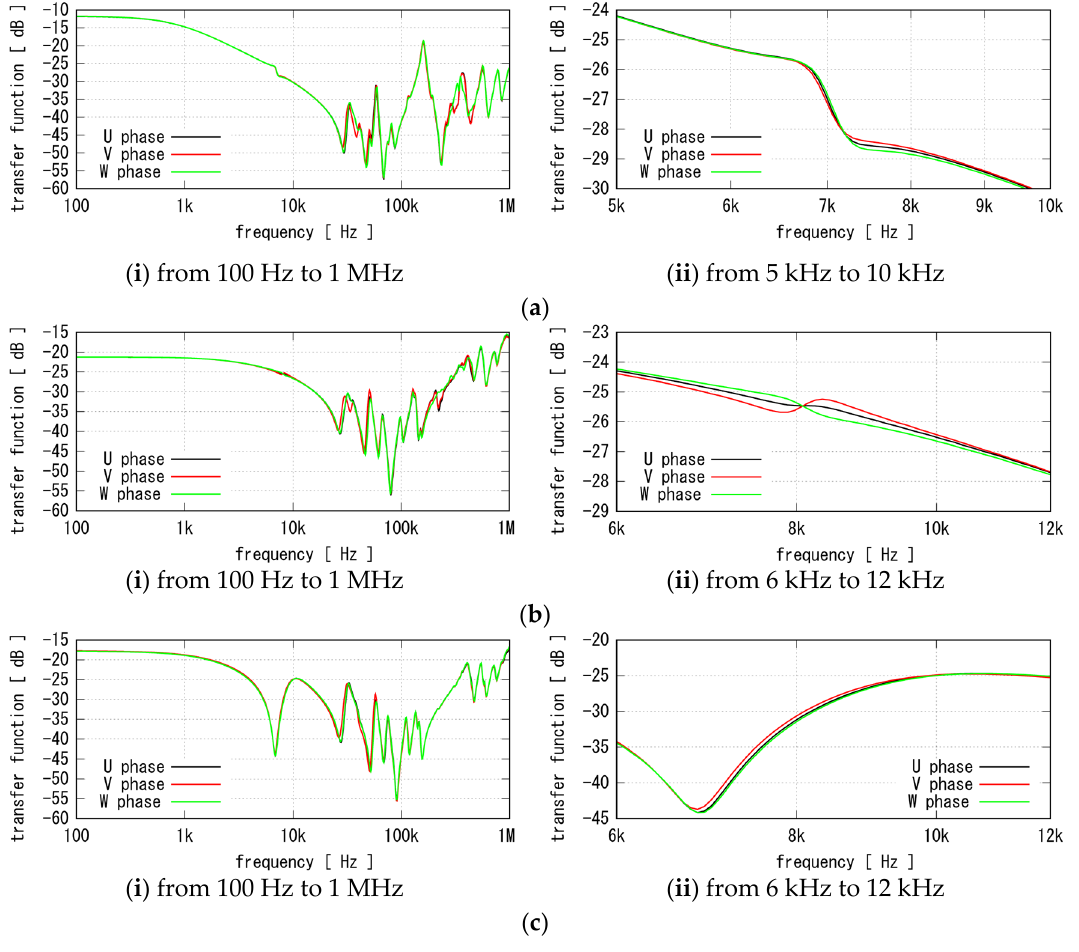
Figure 6. Examples of measured TFs in IIW measurement: ( a ) Stair-type RBS (Tr-A4), ( b ) crossing- curve type RBS (Tr-A1), and ( c ) TFs without RBS (Tr-A2).